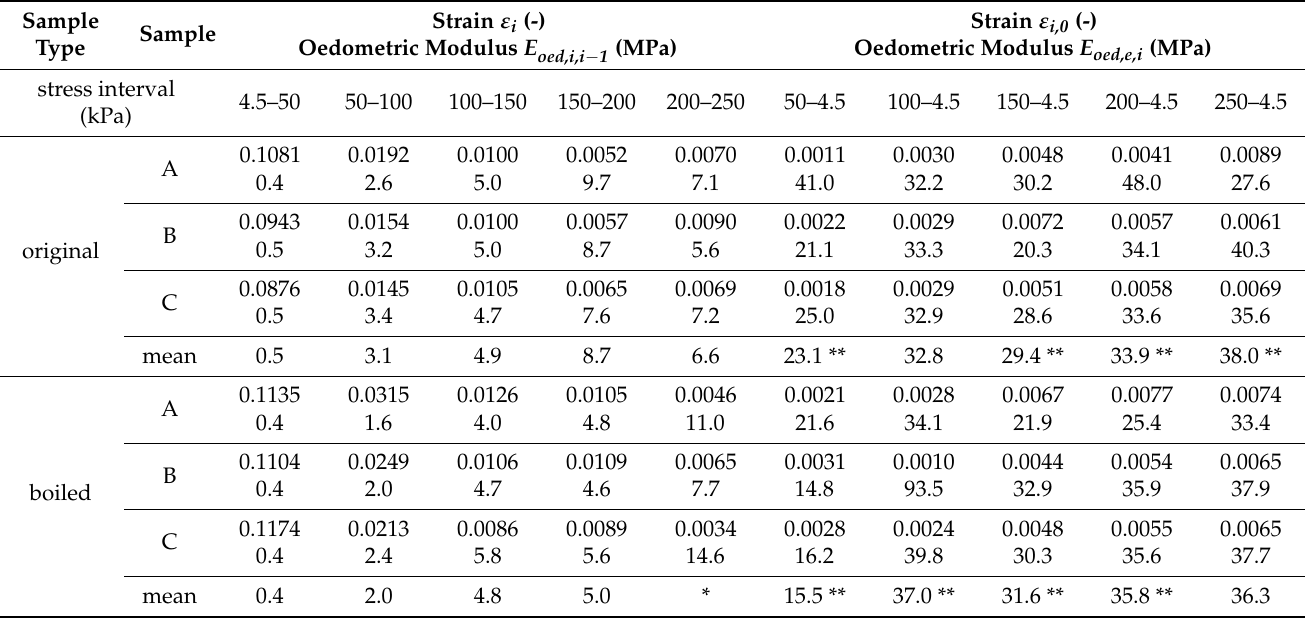
Table 6. Oedometric modulus of kinetic sand for loading and